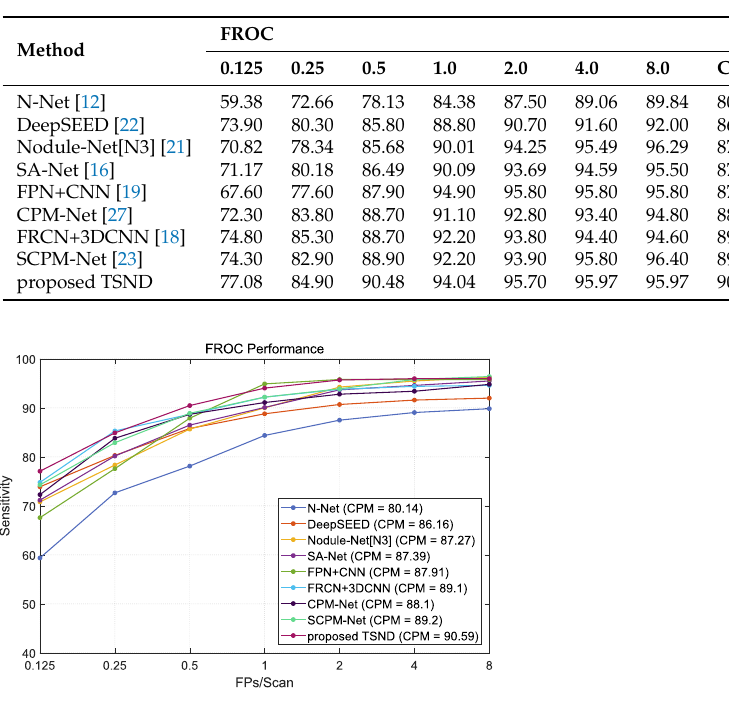
Table 6. Comparison of the FROC metrics between other state-of-the-art methods and our proposed two-stage nodule detection (TSND) using the 10-fold cross-validation on the LUNA16. (FPR: false positive reduction) .